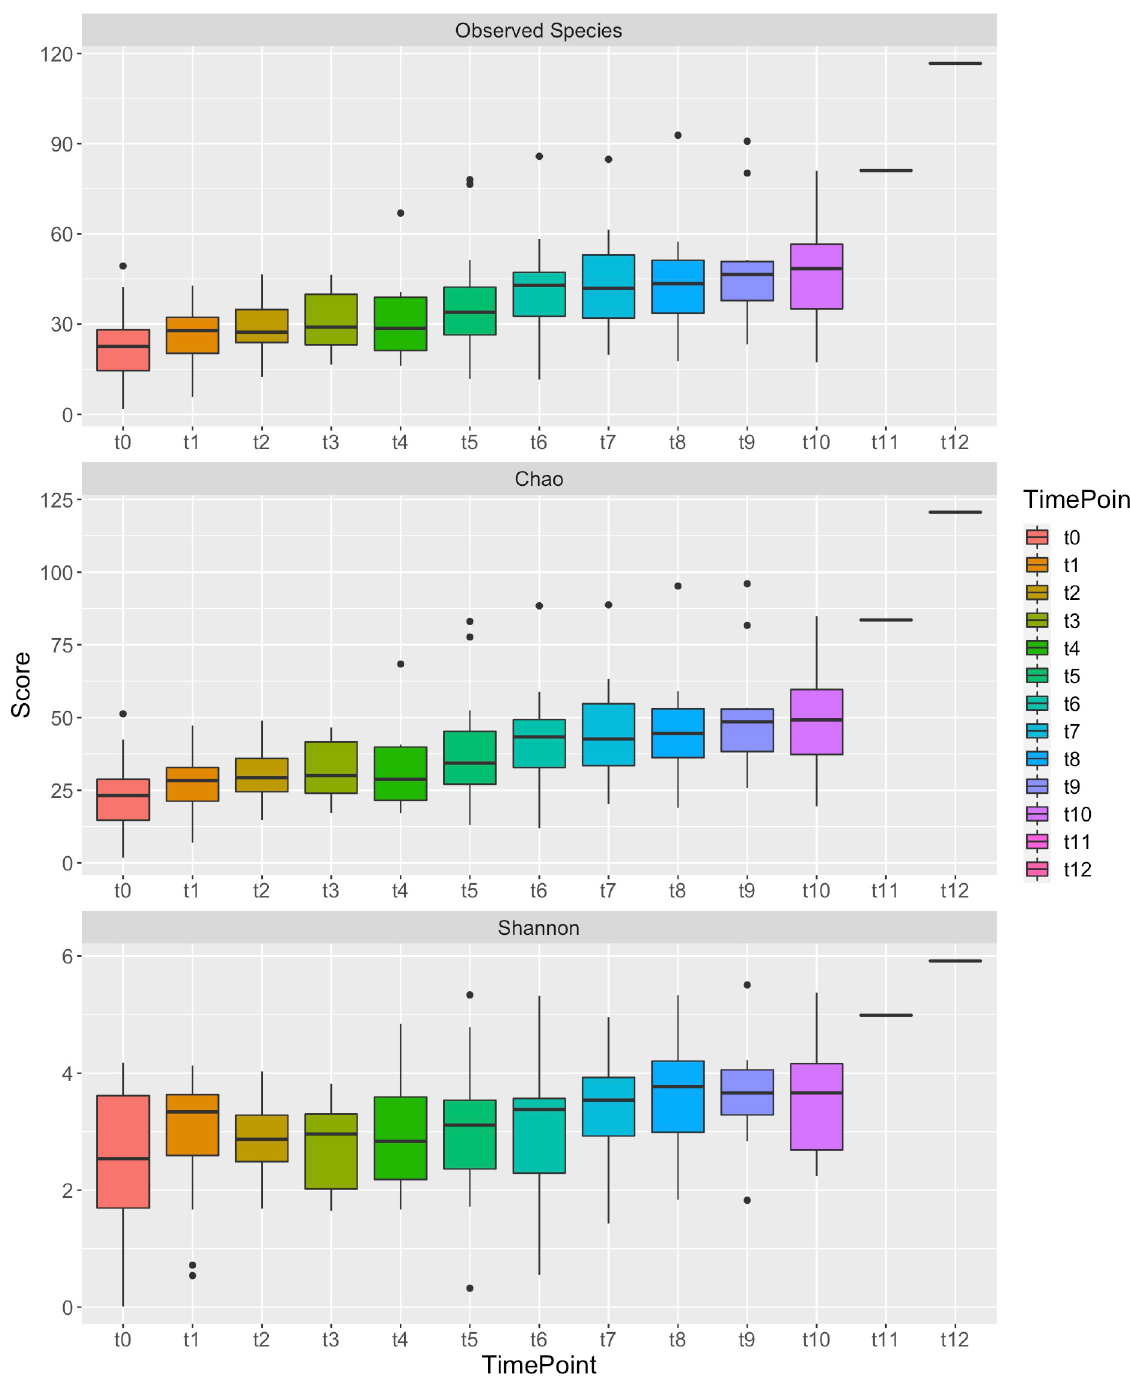
Fig 2. Change in alpha diversity over time of samples collected from all babies. Samples grouped by time points showing the increasing diversity of the gut microbial composition with age. The preweaning samples were significantly different to the samples collected after weaning commenced (LF/SF) for each diversity metric shown (Observed Species p = 1.412 − 07 , Chao p = 9.013 − 08 , and Shannon p = 0.01055; Kruskal Wallis analysis). Samples from a single baby were available for timepoints t11 and t12.